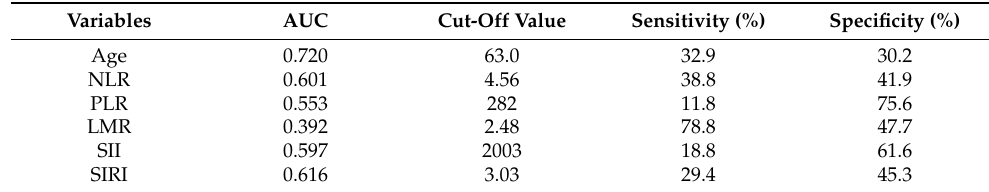
Table 4. The statistical characteristics of the ROC curve for the univariate logistic model for Grade 4 tumour patients ( n = 178).